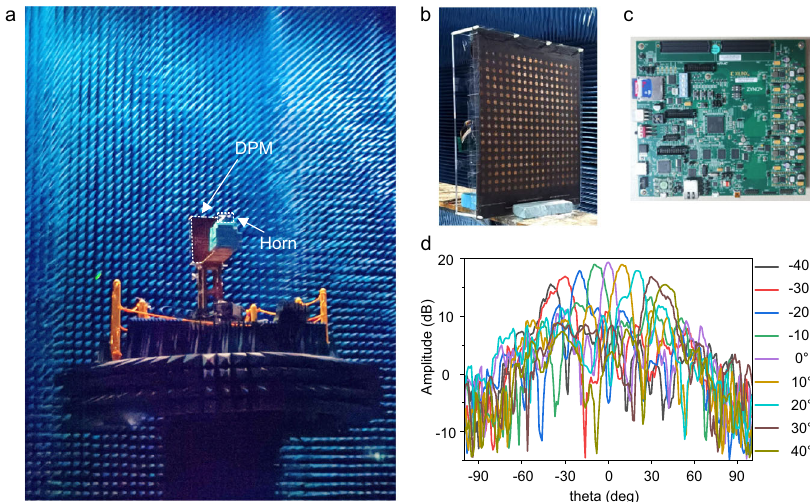
Fig. 3 | Measurements of the manufactured DPM. a The far- fi eld experimental setupinananechoicchamber. b Photographsof thefabricatedprototype. c Zynq- 7000SoC series FPGAforvoltagecontrol. d The measured far- fi eldpatternswhen